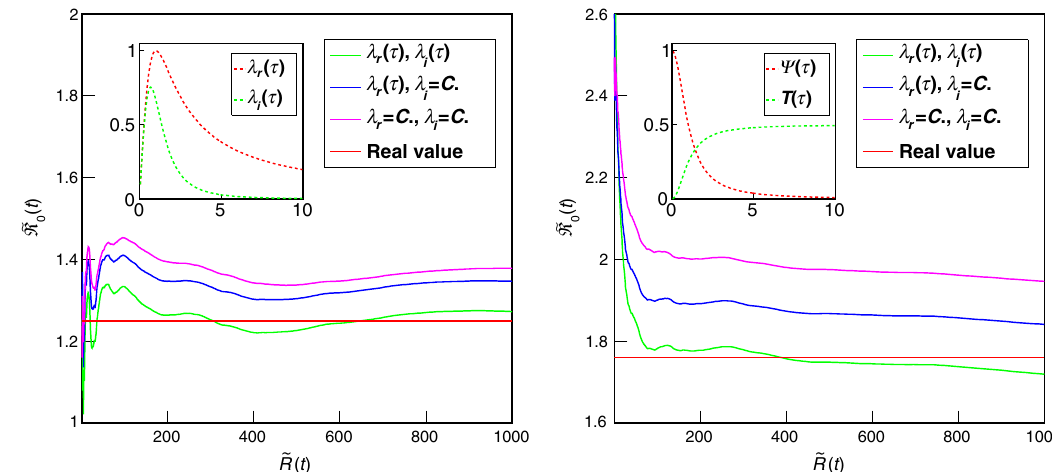
FIG. 11. The estimated basic reproduction number for the binomial [left panel: z 1 ¼ 5 , (cid:1) i ¼ (cid:2)= ð 1 þ (cid:2) 2 Þð 1 þ 0 : 5 (cid:2) 2 Þ , and 2 (cid:2)= ð 1 þ (cid:2) 2 Þ ] and exponential (right panel: (cid:5) ¼ 4 ) networks in terms of the number of removed individuals. The red line and (cid:1) r ¼ green curves correspond to the real and the estimated value. The blue line shows the estimates if we incorrectly assume that (cid:1) i is constant. The pink line shows the corresponding estimates if we incorrectly assume that both (cid:1) i and (cid:1) r are constant.